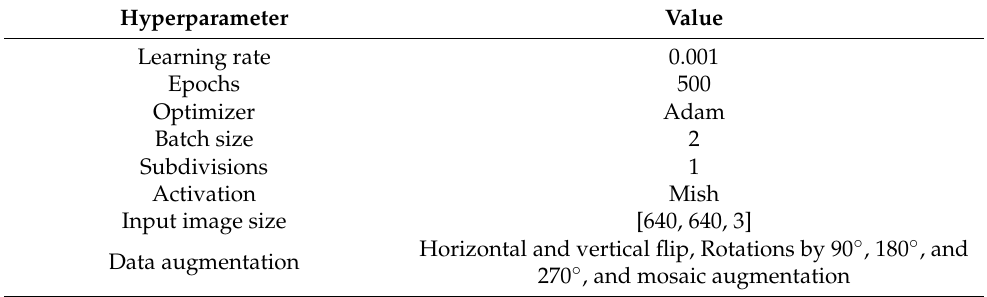
Table 2. Hyperparameters selected for the training of the YOLOv4 model.